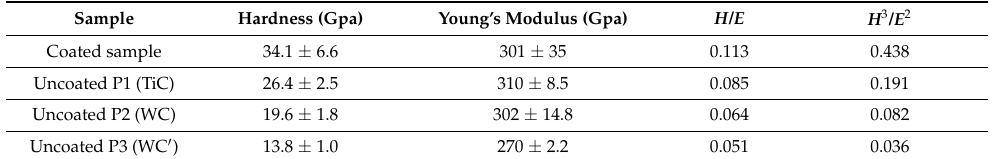
Table 2. Hardness, Young’s modulus and relation between both values measured in the nanoindenta- tion tests for coated and uncoated